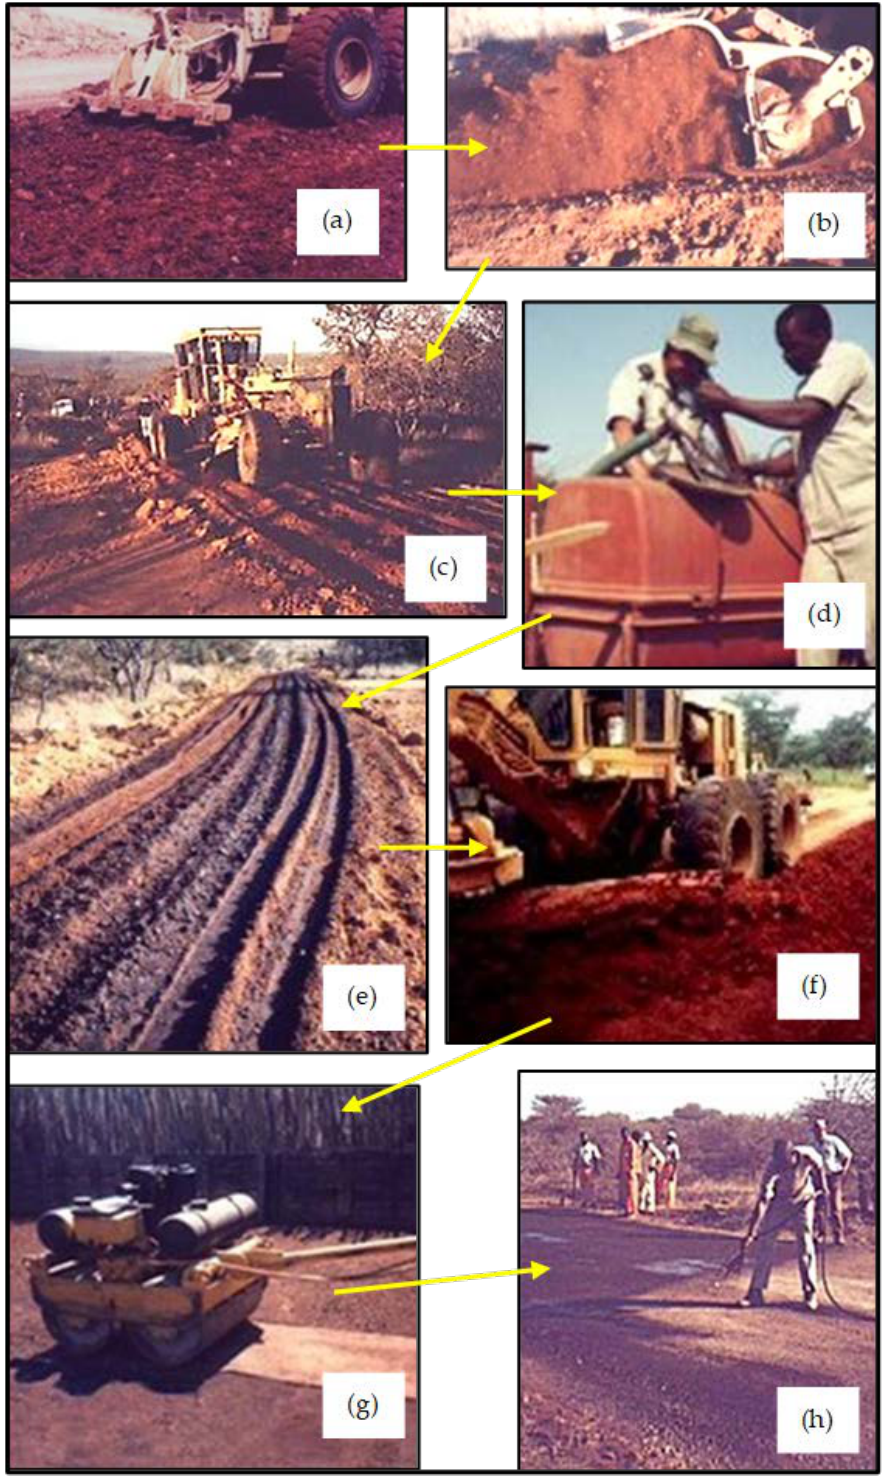
Figure 18. ( a ) Ripping by grader and ( b ) scarifying of in situ material using a rotavator to both loosen material to the required depth and expose oversized material for removal by hand. ( c ) Ripping of layer to create layer depth exposure for ease of application of the construction water-diluted anionic NME stabilising agent. ( d ) Mixing of the NME stabilising agent in a rudimentary water tanker. ( e ) Spraying of the diluted NME onto the exposed material for easy mixing. ( f ) Mixing of material and cutting to level for compaction. ( g ) Compaction of the NME-stabilised base material using hand compactors. ( h ) Applying a prime coat by hand sprayer.